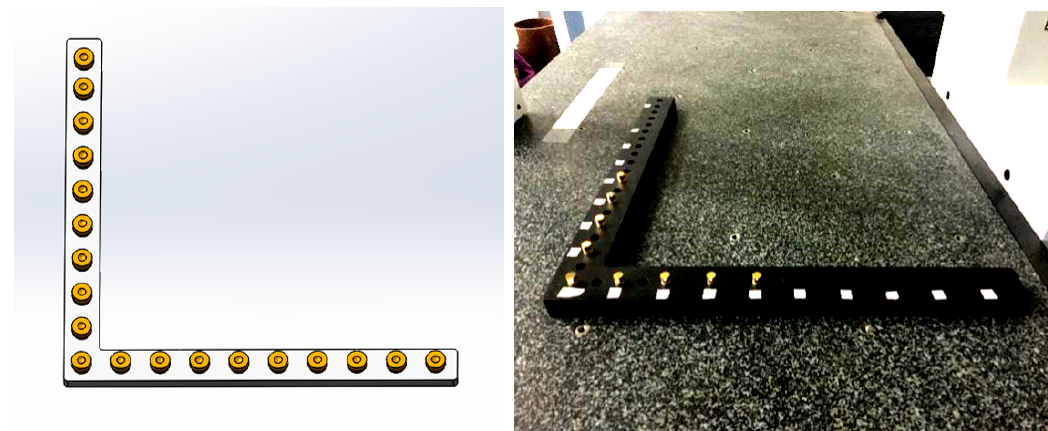
Figure 12. L-shaped rotating paraboloid checker.